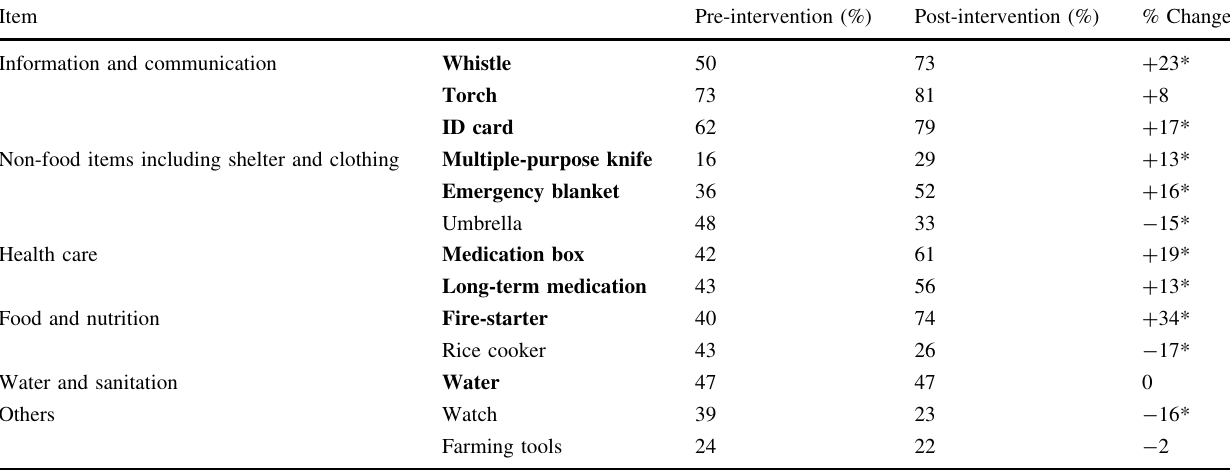
Table 2 List of items covered in the 2014 pre- and post-intervention household questionnaire on the content of a disaster preparedness kit ( n = 100) in Hongyan village (necessary items in bold)